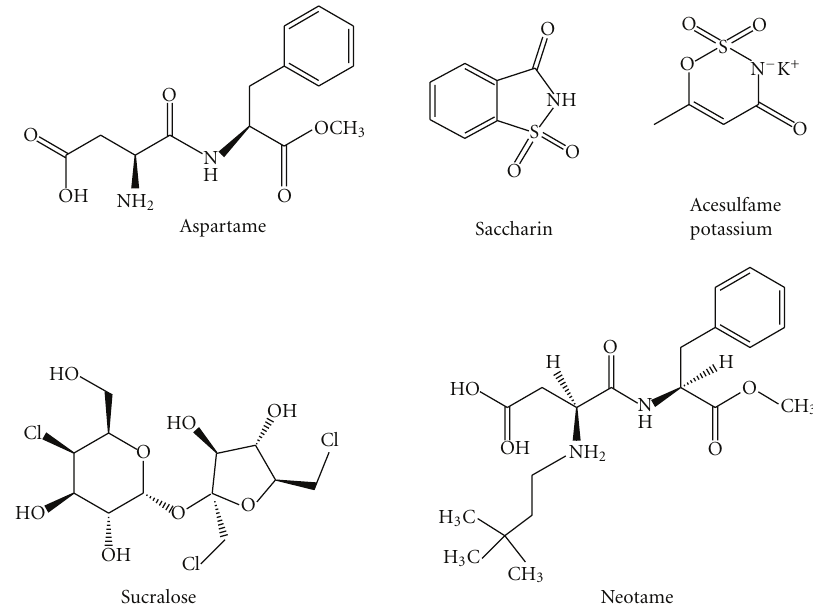
Figure 1: Chemical structure of FDA approved non-/low caloric sweeteners as food